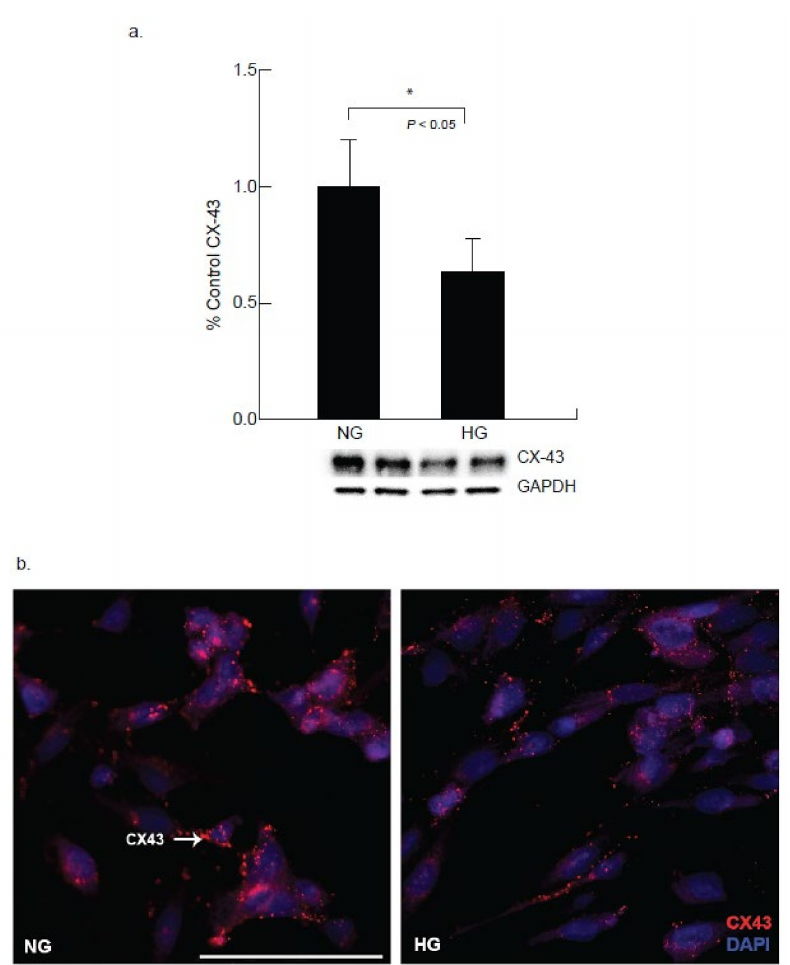
Figure 1. Hyperglycemic condition results in alterations in Connexin 43 expression in cardiomyocytes. Gap junction protein connexin 43 (Cx43) expression was assessed by Western blot analysis as well as by immunohistochemistry in cardiomycytes. ( a ). Western blot analysis demonstrated a decrease in CX43 expression in the hyperglycemia exposed cardiomyocytes compared to the normoglycemic condition (NG, * p < 0.05). ( b ). Immunocytochemical analysis also exhibited reduced CX43 expression (red) in CM under hyperglycemic condition compared to cardiomyocytes under normal glucose condition after 24 h of exposure. (Scale bar = 100 µ